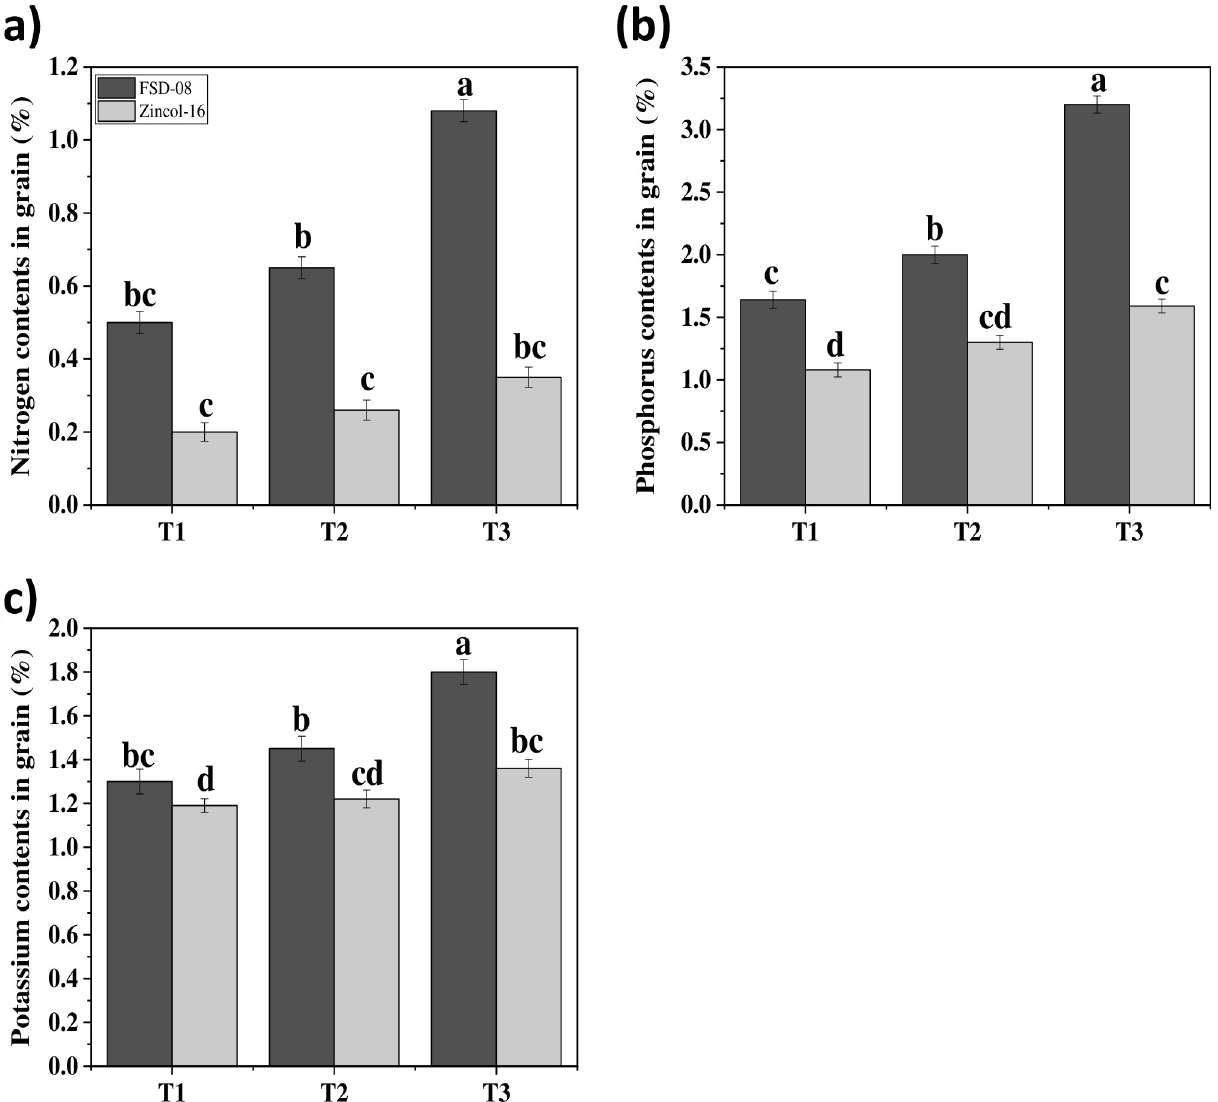
Fig 5. The effect of exogenous caffeic acid supply on (a) nitrogen contents, (b) phosphorus contents and (c) potassium contents in grains of two wheat ( Triticum aestivum L.) varieties subjected to salt stress. The bar values depict the average of three replications and the bars not sharing the same lowercase letters differ significantly from each other according to the HSD test at P < 0.05 probability. Treatments include (T 1 ) Saline field EC 8.7 dS m -1 , (T 2 ) saline field + 50 μ M caffeic acid, (T 3 ) saline field + 100 μ M caffeic acid.